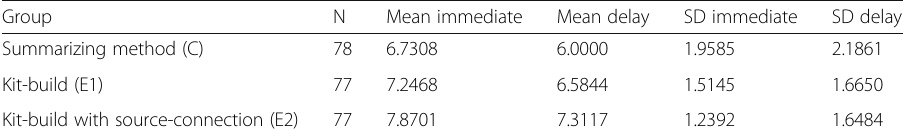
Table 4 Mean of the immediate and delay tests of Material 1 in all groups Group